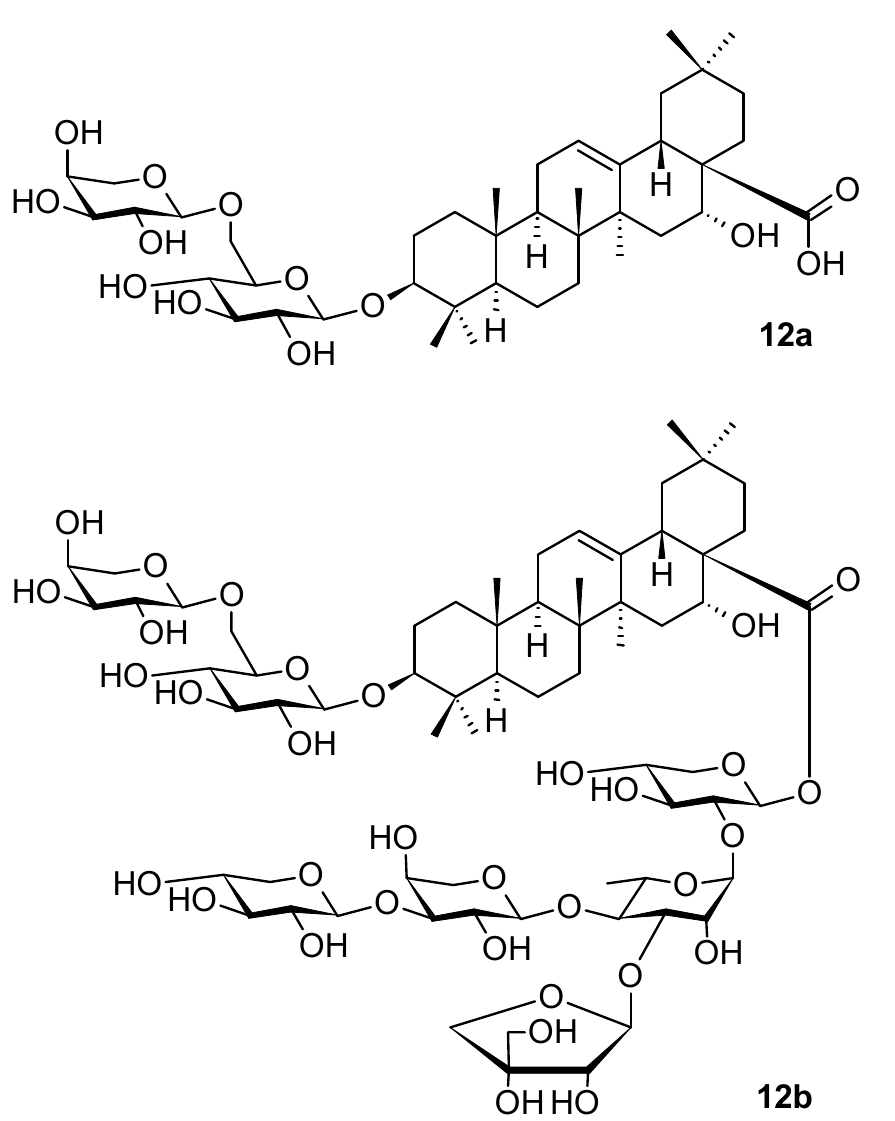
Figure 12. Oleanane-type triterpenoids from Aster tataricus.